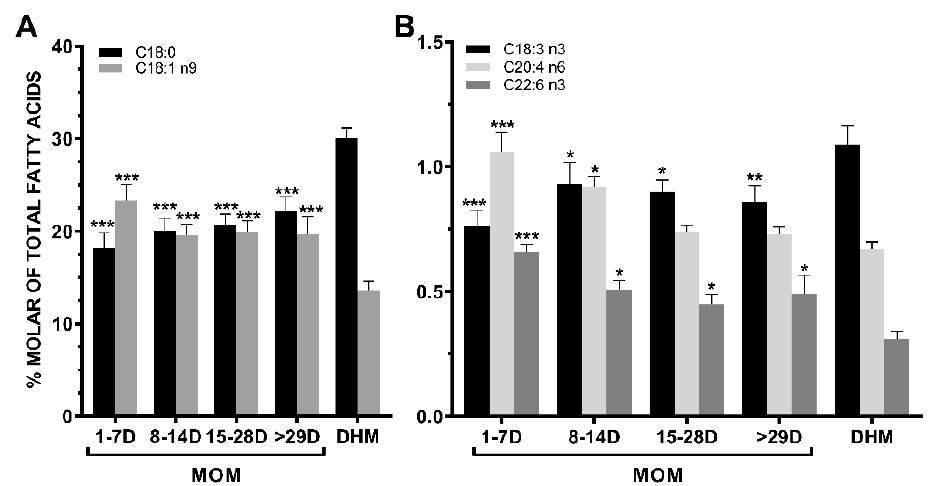
Figure 2. ( A ) The stearic acid (C18:0) and the oleic acid (C18:1 n-9) showed quite symmetrical but opposite trends in mothers’ own milk (MOM) during the different stages of lactation. Donor human milk (DHM) showed a significantly higher content of stearic acid and lower content of oleic acid (colostrum 1–7 days, transitional milk 8–14 days, mature mild 15–28 days and ≥ 29 days). ( B ) In MOM samples, α-linolenic acid (C18:3 n3) and DHA (C22:6 n3) showed a different and opposite pattern increasing and decreasing from colostrum to transitional milk, respectively. Arachidonic acid (AA) (C20:4 n6) levels in MOM samples decreased from colostrum to mature milk. Donor human milk is markedly deficient in DHA content. Asterisks indicate significant differences (* p < 0.05; ** p < 0.01; *** p < 0.001) in each group vs. DHM sampling points.